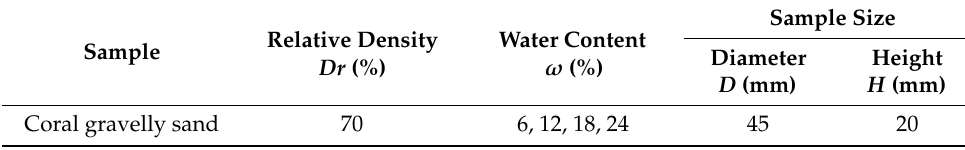
Table 3. Nuclear magnetic resonance experiment